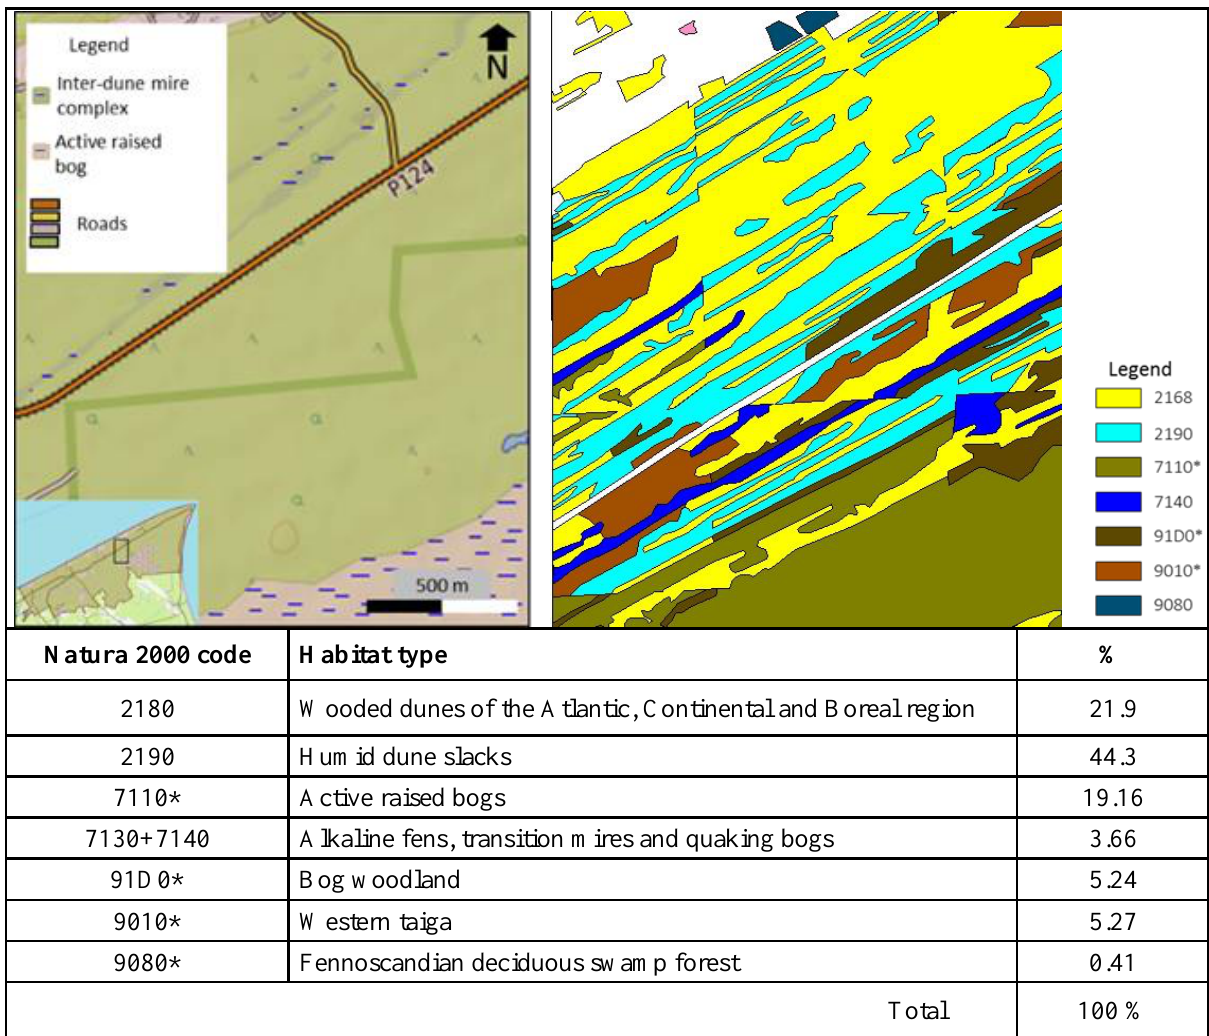
Figure 6. Occurrence of Natura 2000 habitat types and their percentage distribution in the study area.